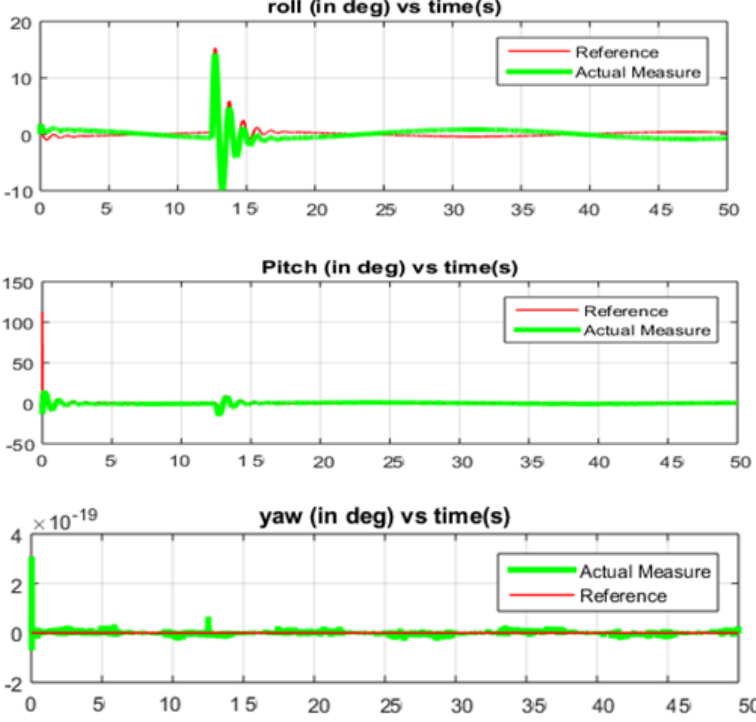
Figure 20. Roll, pitch and yaw responses using SDF-SMC control technique.